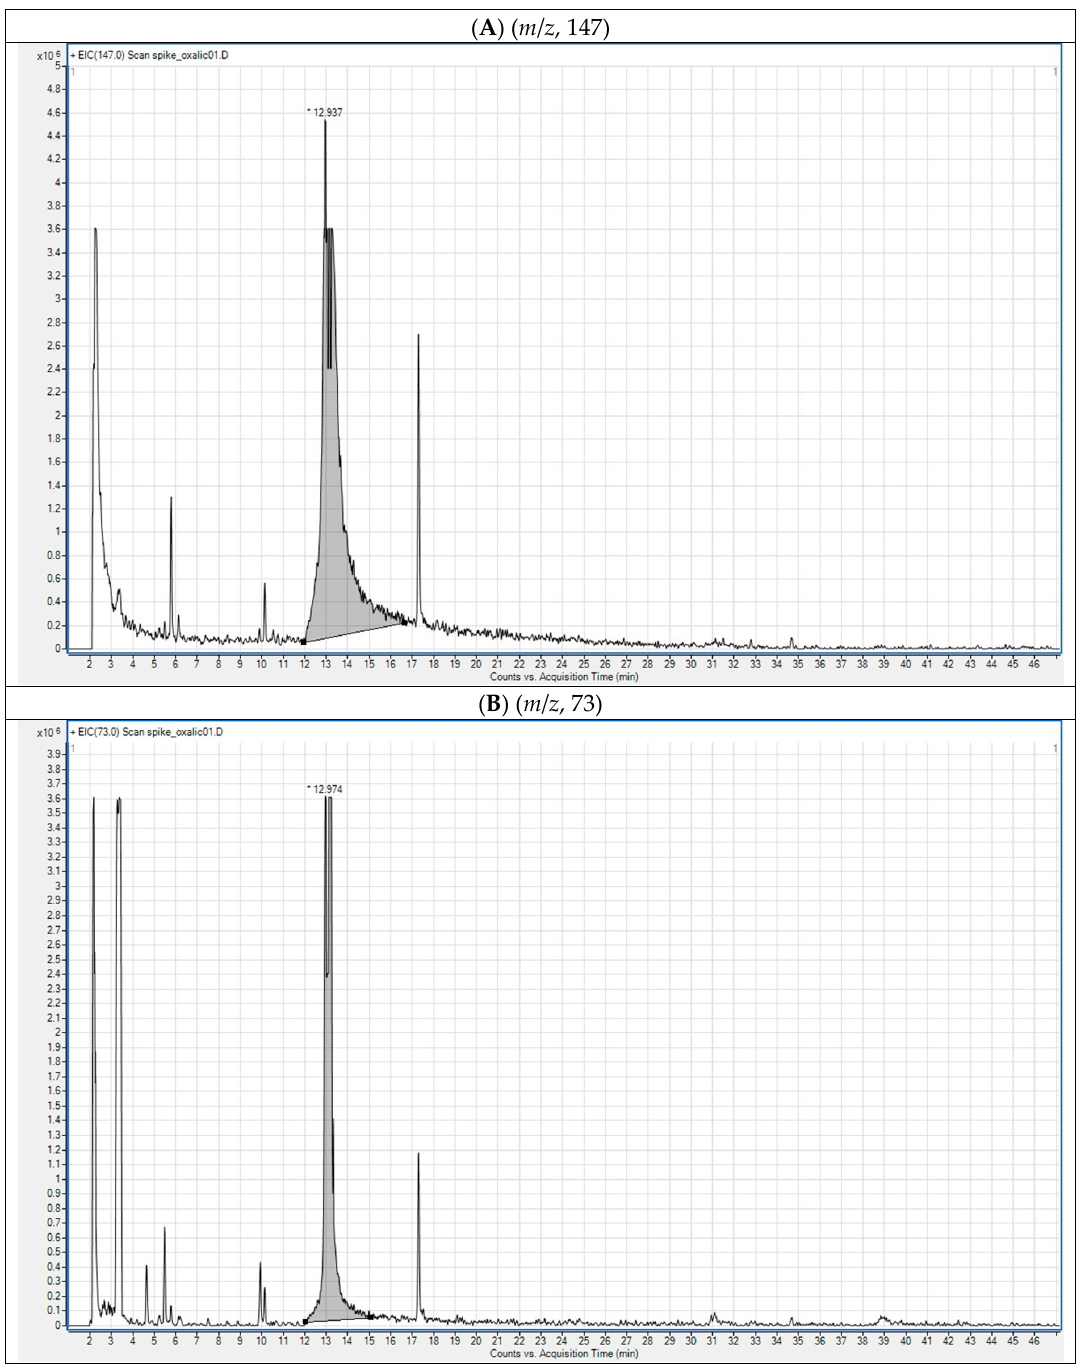
Figure 3. GC-MS extracted ion chromatograms ( A , B ) of a spiked derivatized OA bee sample at 1 μ g/mL.